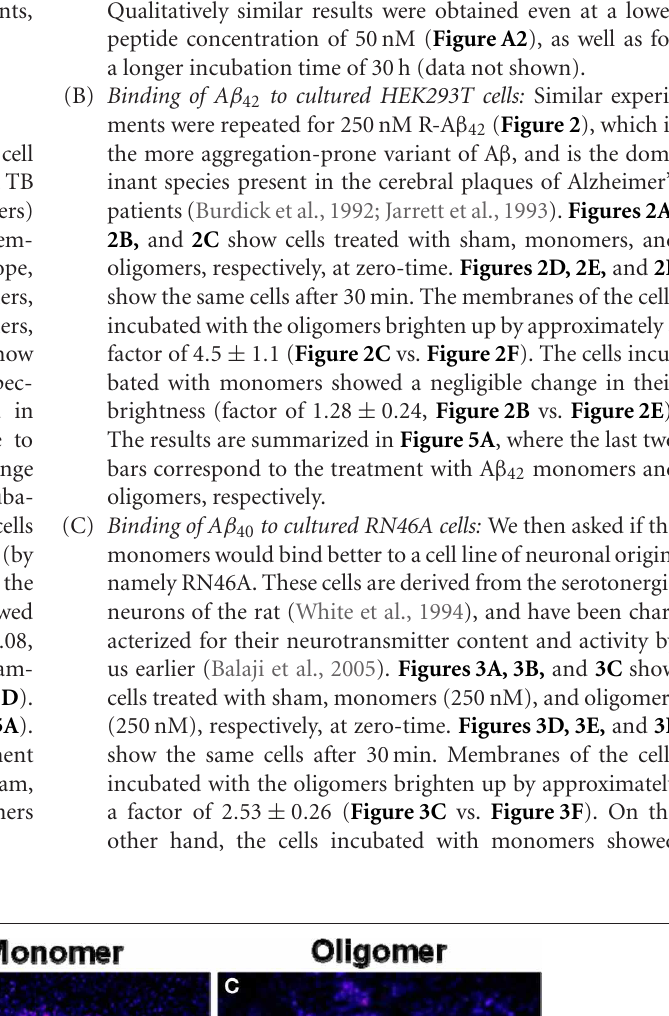
30min of incubation with buffer (D) , 250nM of monomeric R-A β 40 (E) , and 250nM of small oligomeric R-A β 40 (F) . Intensity is false color coded. Scale bar = 20 μ